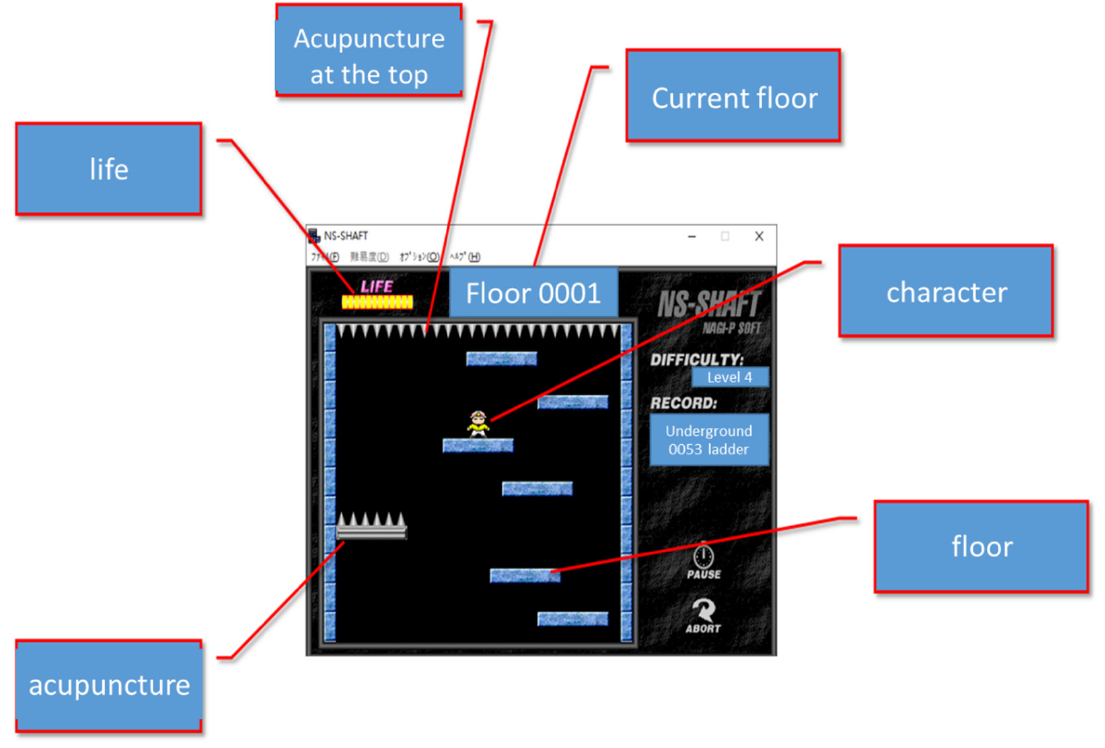
Figure 1. NS-SHAFT screen.